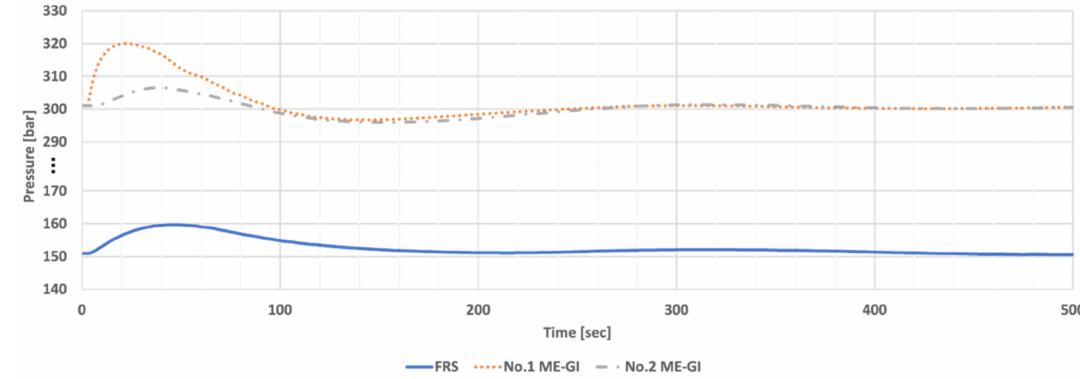
Figure 17. Pressure of each line when one engine is tripped.